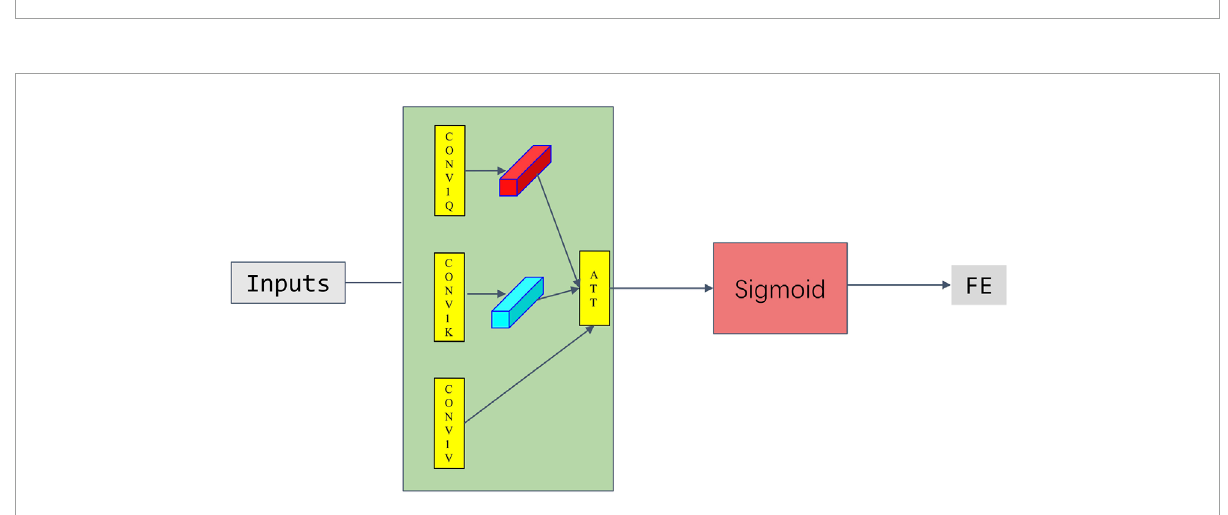
FIGURE 2 Pre-processed direct horizontal irradiance data from Lyon, France.